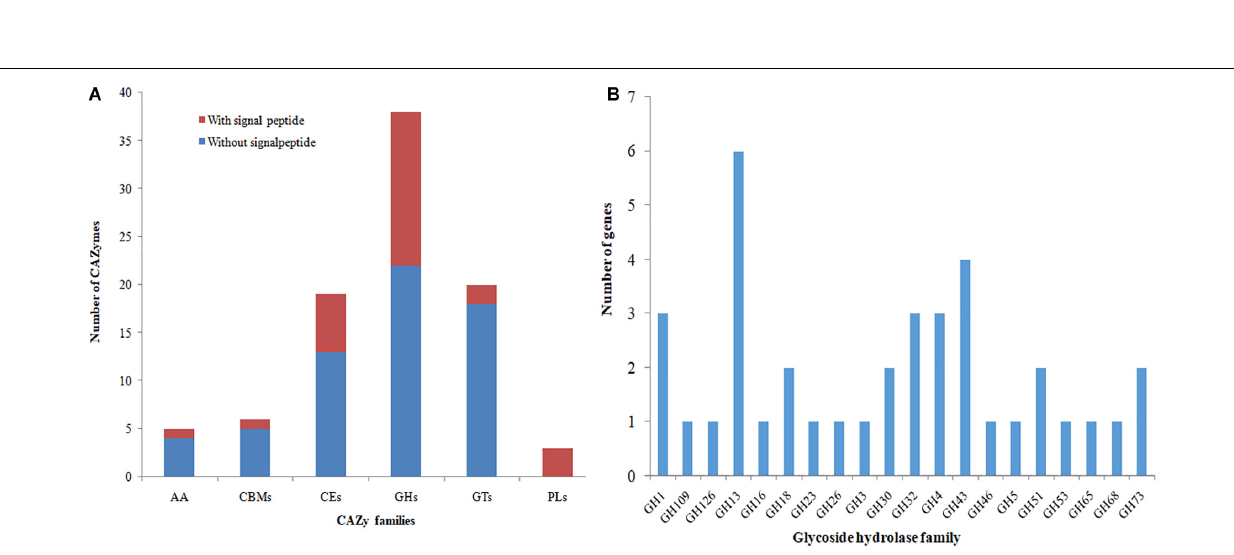
Frontiers in Microbiology |